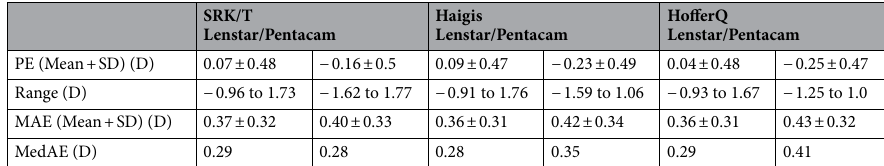
Table 1. Postoperative outcomes: Refraction prediction error with the Lenstar and Pentacam. PE mean predicted error calculated as the difference between the measured and predicted postoperative refractive spherical equivalent, MAE mean absolute error, MedAE median absolute error.